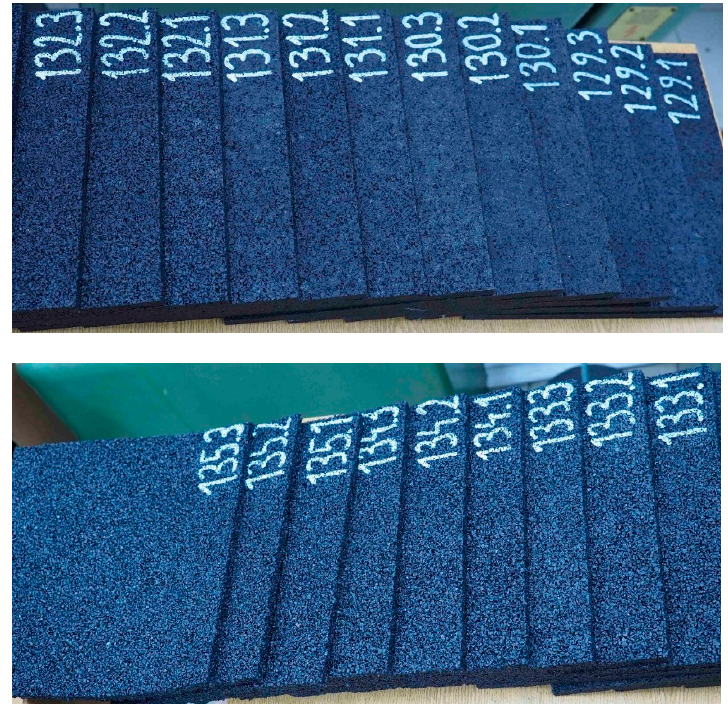
Figure 2. SBR samples with visible porosity increase for the materials with lower densities (higher numbers).